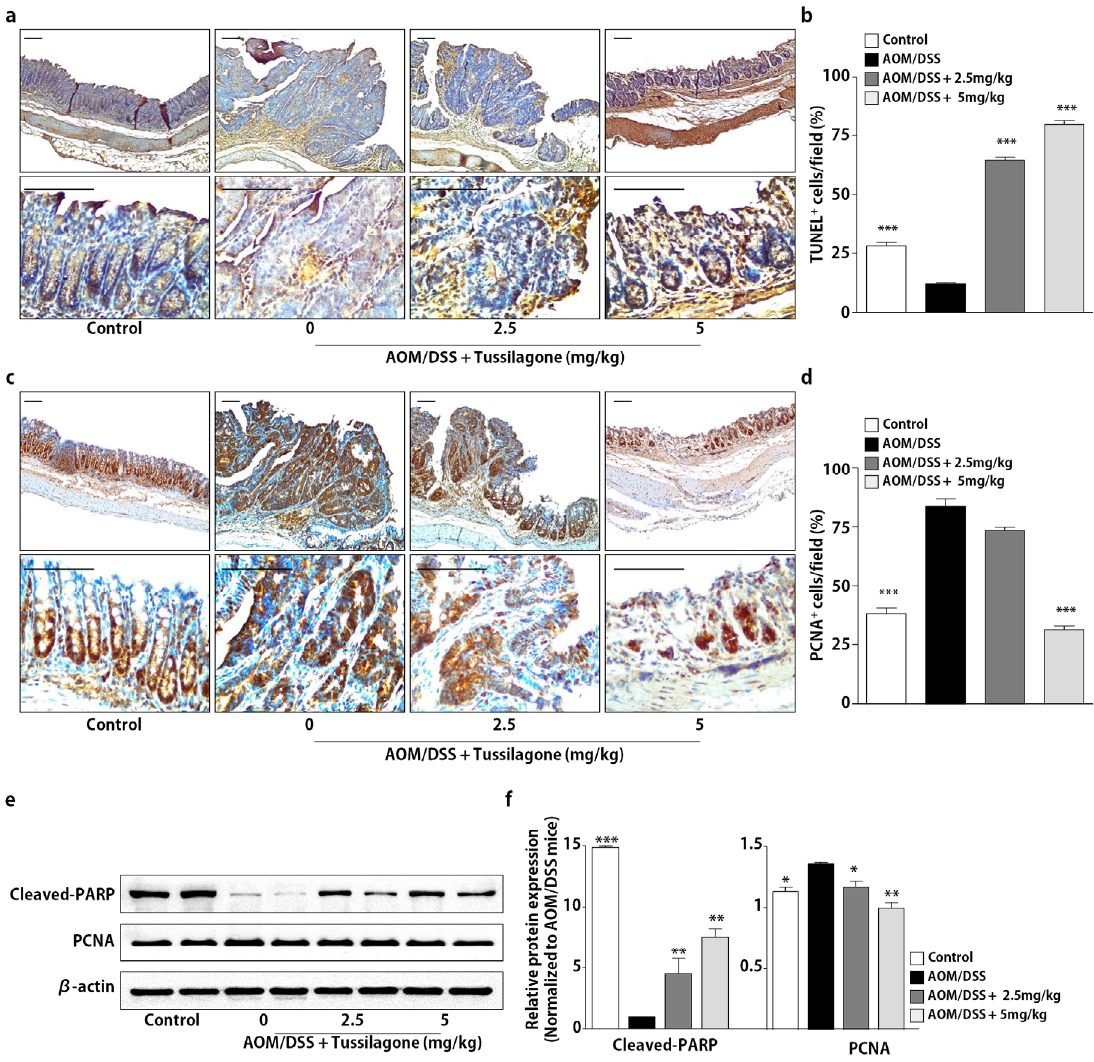
Figure 4. Tussilagone treatment induces apoptosis and inhibits cell proliferation in the colon. ( a ) Apoptosis was measured via terminal deoxynucleotidyl transferase dUTP nick end labeling (TUNEL) staining of the colon sections of mice (upper, × 100 magnification; lower, × 400 magnification; bar = 100 µ m). ( b ) The percentage of TUNEL-positive cells in the colon tissues was estimated as described in Methods. ( c ) The cell proliferation was measured via PCNA staining of the colon sections from mice (upper, × 100 magnification; lower, × 400 magnification; bar = 100 µ m). ( d ) The percentage of PCNA-positive cells in the colon tissues was calculated as described in Methods. ( e ) The protein samples of the whole-cell lysates from the colon tissues were separated by SDS-PAGE. Cleaved-PARP and PCNA were detected by Western blot and visualized by chemiluminescence. Photos are representative images. ( f ) The quantitative data were normalized by internal control, β -actin and further expressed as folds, presented as the comparison with the amount relative to the AOM / DSS-treated mice. The results are expressed as the mean ± SEM, * P < 0.05, ** P < 0.01, *** P < 0.001, compared with the AOM / DSS-treated